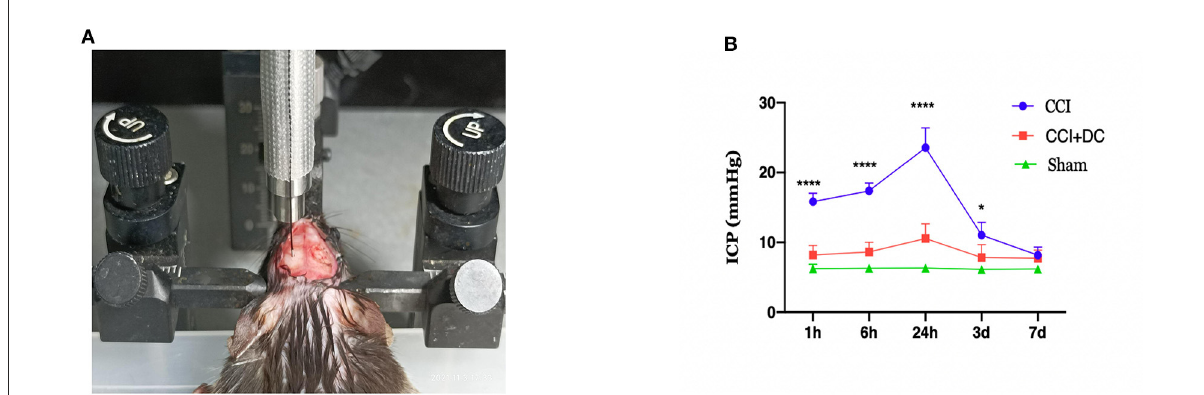
FIGURE3 Intracranial pressure monitoring in mice. (A) Diagram for monitoring ICP in mouse. (B) Time-varying curves of ICP of mice in each group. Compared with the sham group, the ICP of the CCI + DC group and the CCI group was higher than that of the sham group after CCI, and the